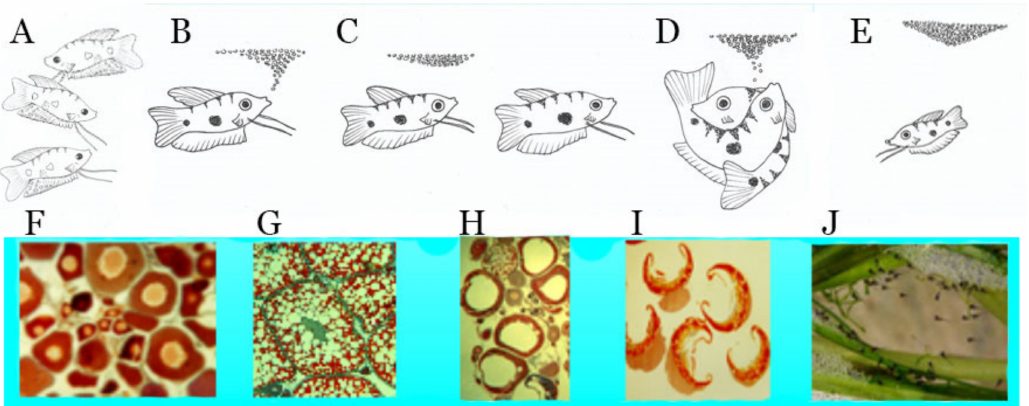
Figure 1. The relationship between sexual behavior, oogenesis and nursing in blue gourami [1]. ( A ) High density—no reproduction occurs. ( B ) The male builds a bubble nest. ( C ) Sexual behavior under the nest. ( D ) The male wraps his body around the female and the female spawns eggs that will be deposited in the nest. ( E ) The bubble nest with eggs in it. ( F ) Oocytes in pre-vitellogenesis. ( G ) Oocytes in vitellogenesis. ( H ) Oocytes in maturation. ( I ) Oocytes in ovulation. ( J ) Fry hatches in the nest